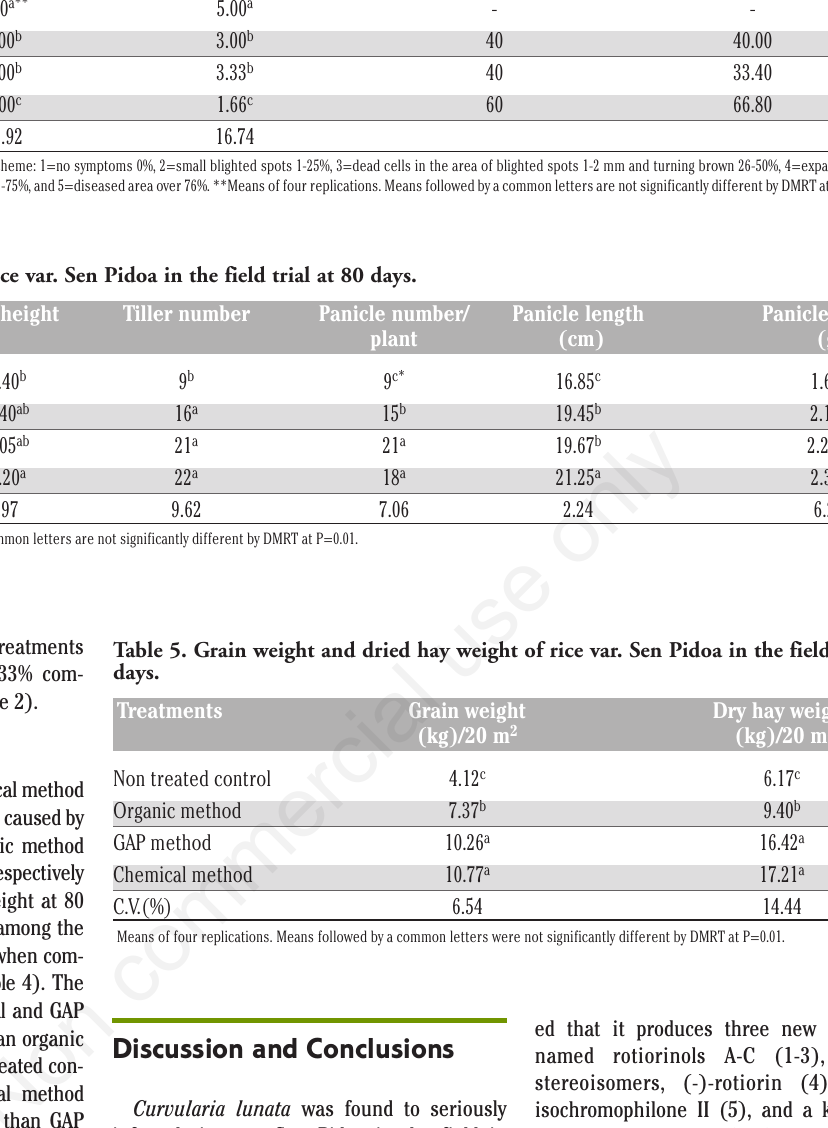
Table 3. Disease index (DI) of leaf spot caused by Curvularia lunata on rice var. Sen Pidoa in field experiment. Treatments DI on leaves* DI in grains Disease reduction Disease reduction and panicles